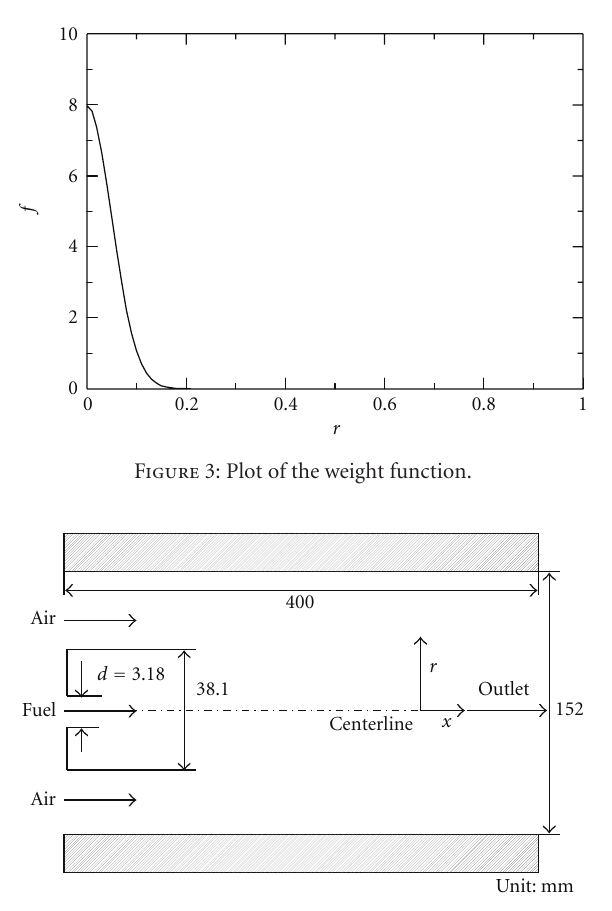
Figure 4: Sketch of computational domain.